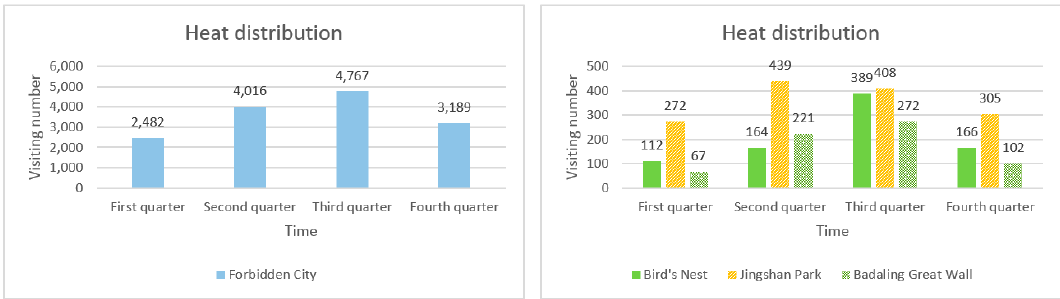
Figure 14. Heat distribution map divided by quarters.